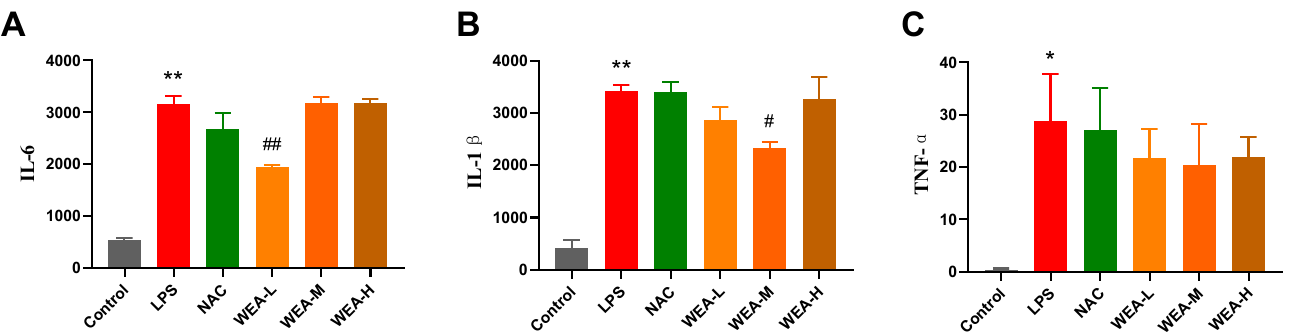
Figure 4. Serum inflammatory factor levels in mice. ( A ) IL-6, ( B ) IL-1 β , and ( C ) TNF- α levels in each group of mice were quantified by ELISA. All values are expressed as mean ± SEM. Compared with Control * p < 0.05, ** p < 0.01. Compared with LPS, # p < 0.05, ## p < 0.01. IL-6,